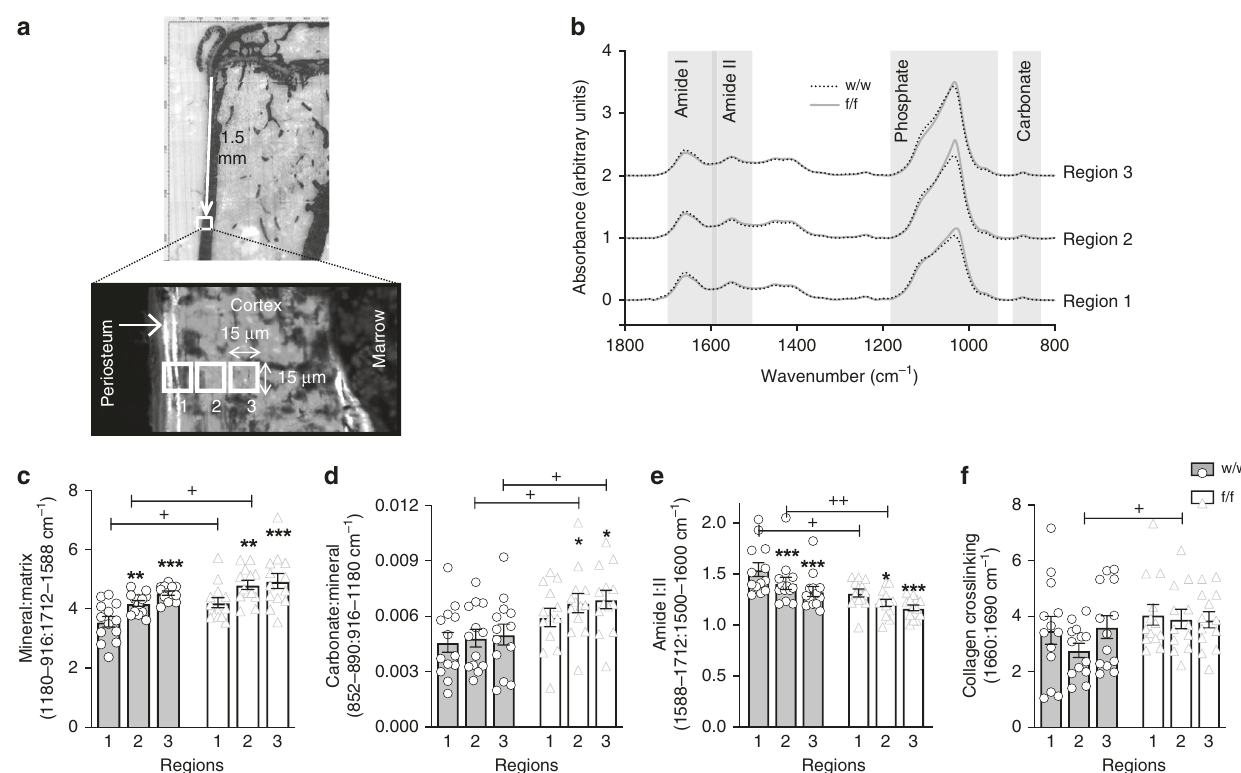
Fig. 3 Elevated mineral accrual, carbonate deposition, and reduced amide I:II ratio in Dmp1Cre.Efnb2 f/f cortical bone. a Regions of periosteal bone used for synchrotron-based Fourier-transform infrared microspectroscopy (sFTIRM) analysis. Note the double calcein label on the newly mineralized periosteum; regions 1 – 3 (15 μ m 2 in size) denote bone areas of increasing maturity with increasing distance from the periosteal edge. b Averaged sFTIRM spectra from regions 1, 2, and 3 of all 12-week old female Dmp1Cre (w/w) and Dmp1Cre.Efnb2 f/f (f/f) tibiae; grey boxes show approximate regions of the amide I, amide II, phosphate, and carbonate peaks (see Method for details). c – f sFTIRM-derived mineral:matrix ( c ), carbonate:mineral ( d ), amide I:II ( e ), and collagen crosslinking ( f ) ratios in regions 1 – 3 of w/w and f/f tibiae. Data are represented as mean ± SEM, with individual values, n = 13/group. * p < 0.05, ** p < 0.01, *** p < 0.001 vs. region 1 of same genotype (bone maturation effect), + p < 0.05, ++ p < 0.01 vs. w/w in the same region (genotype effect) by